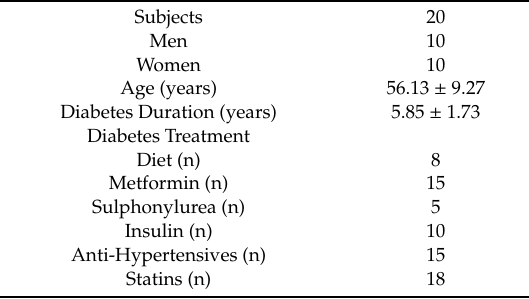
Table 1. Characteristics and pharmacological treatment at